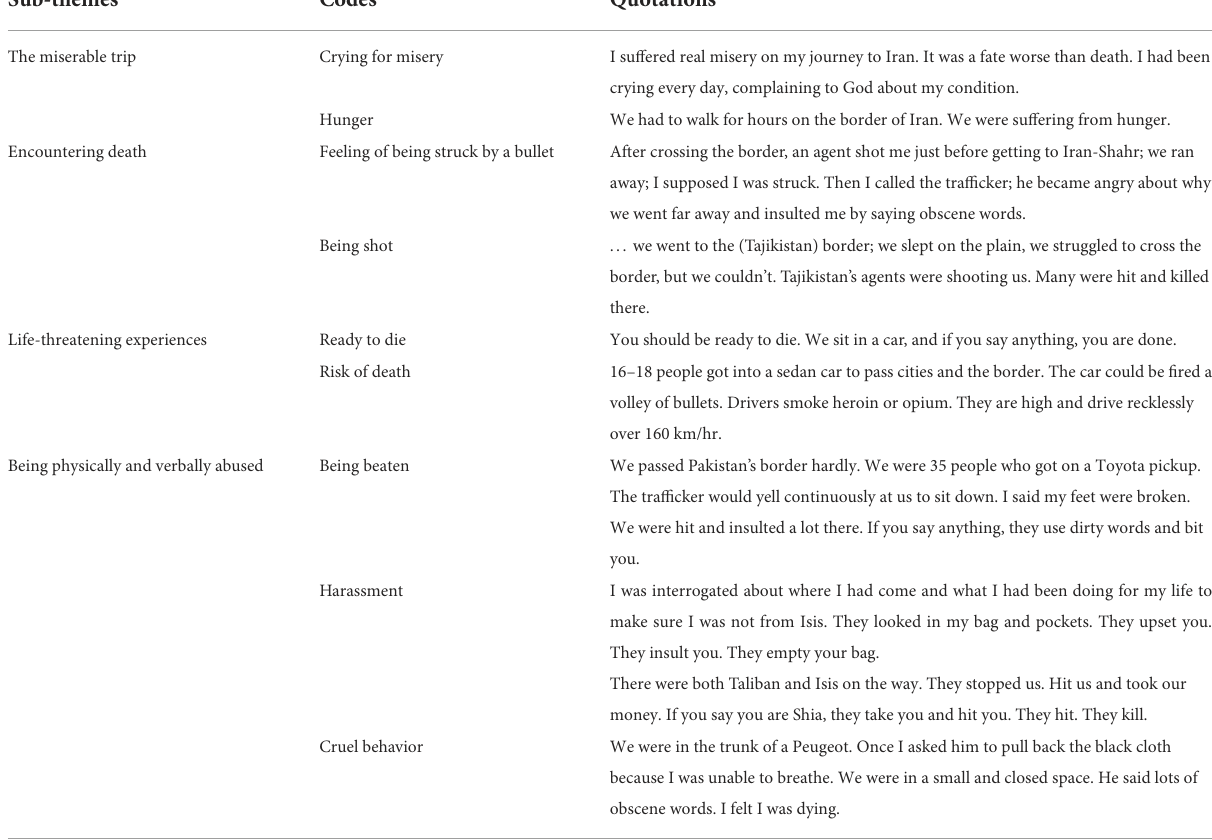
TABLE 2 Sub-themes, codes and quotations of the Traumatic Escape